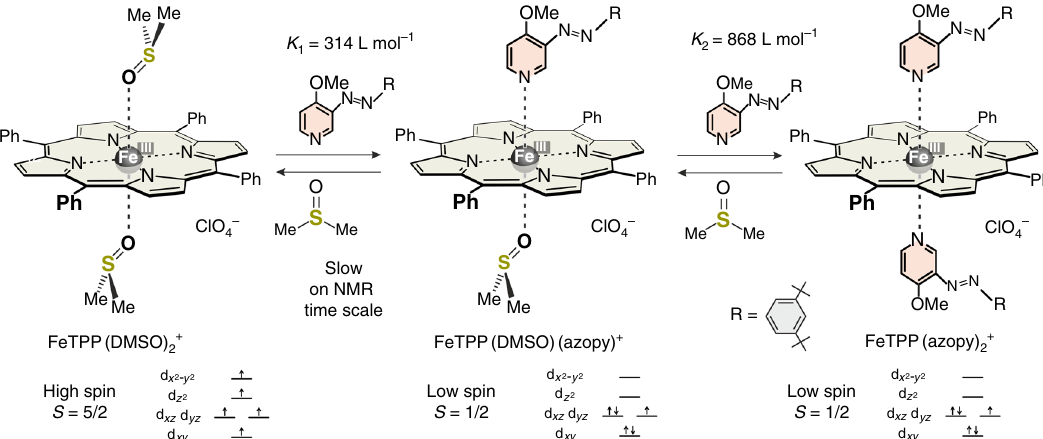
Fig. 4 Titration of high-spin FeTPP(DMSO) 2 + with the photodissociable ligand (PDL) azopyridine. The binding isotherm was derived from the decrease of the UV – vis absorption band at 686 nm upon addition of the trans azopyridine to a solution of 0.1 mM FeTPP + , and 25.87 mM DMSO- d 6 in acetone- d 6 at 25 °C (see Methods, Far – vis spectroscopy of the spin-state changes and Calculation of apparent equilibrium constants). The binding constants K 1 and K 2 were determined under the assumption that the mixed complex FeTPP(DMSO)(azopy) + is Figure 36 and Methods, EPR spectroscopy), and the UV – vis absorption at 686 nm almost completely vanished (Supplemen- tary Figure 20a). According to Evans measurements (see Meth- ods, Magnetic susceptibility — Evans measurements), the effective